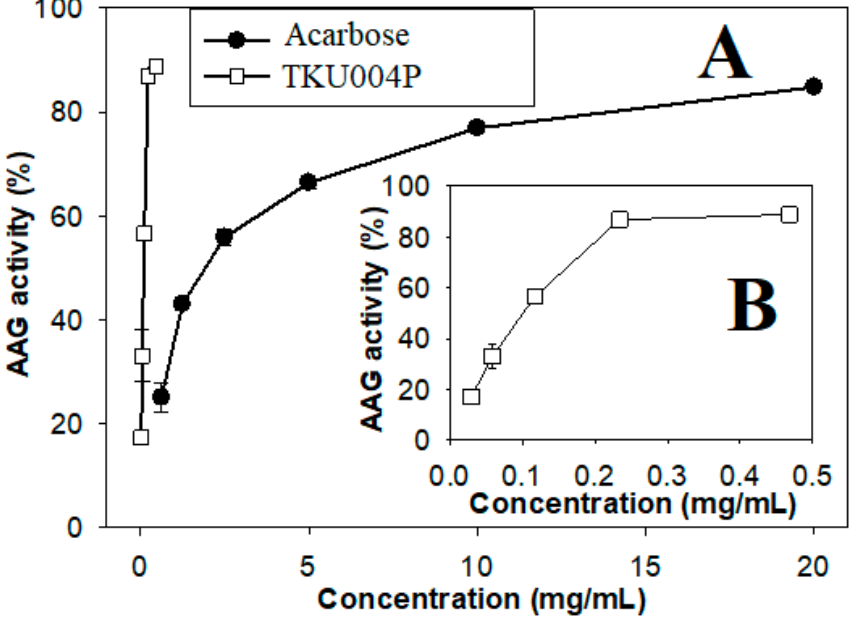
Figure 2. Anti- α -glucosidase (AAG) activity of TKU004P and acarbose. ( A ) Concentration range of 0–20 mg/mL; ( B ) concentration range of 0–0.5 mg/mL.